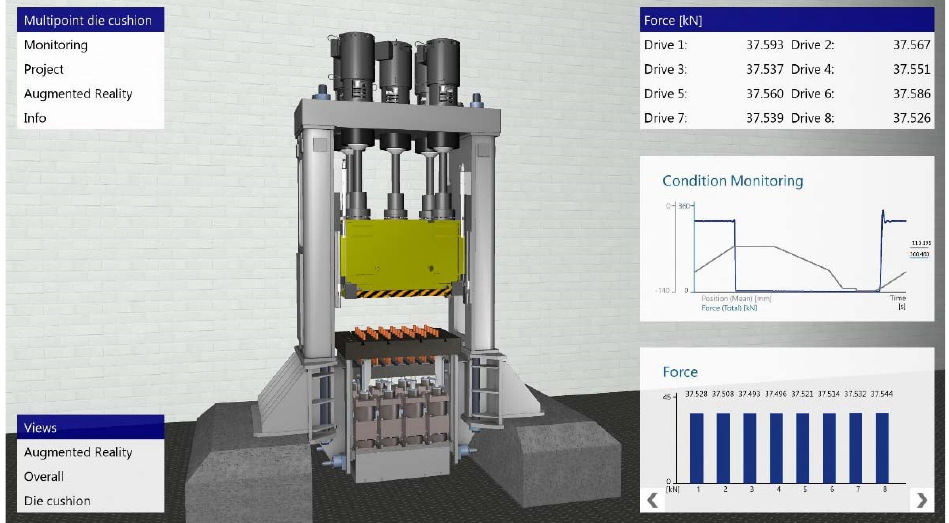
Figure 4. 3D visualization of the press, including the die cushion and monitoring charts, to show the current process with online data.